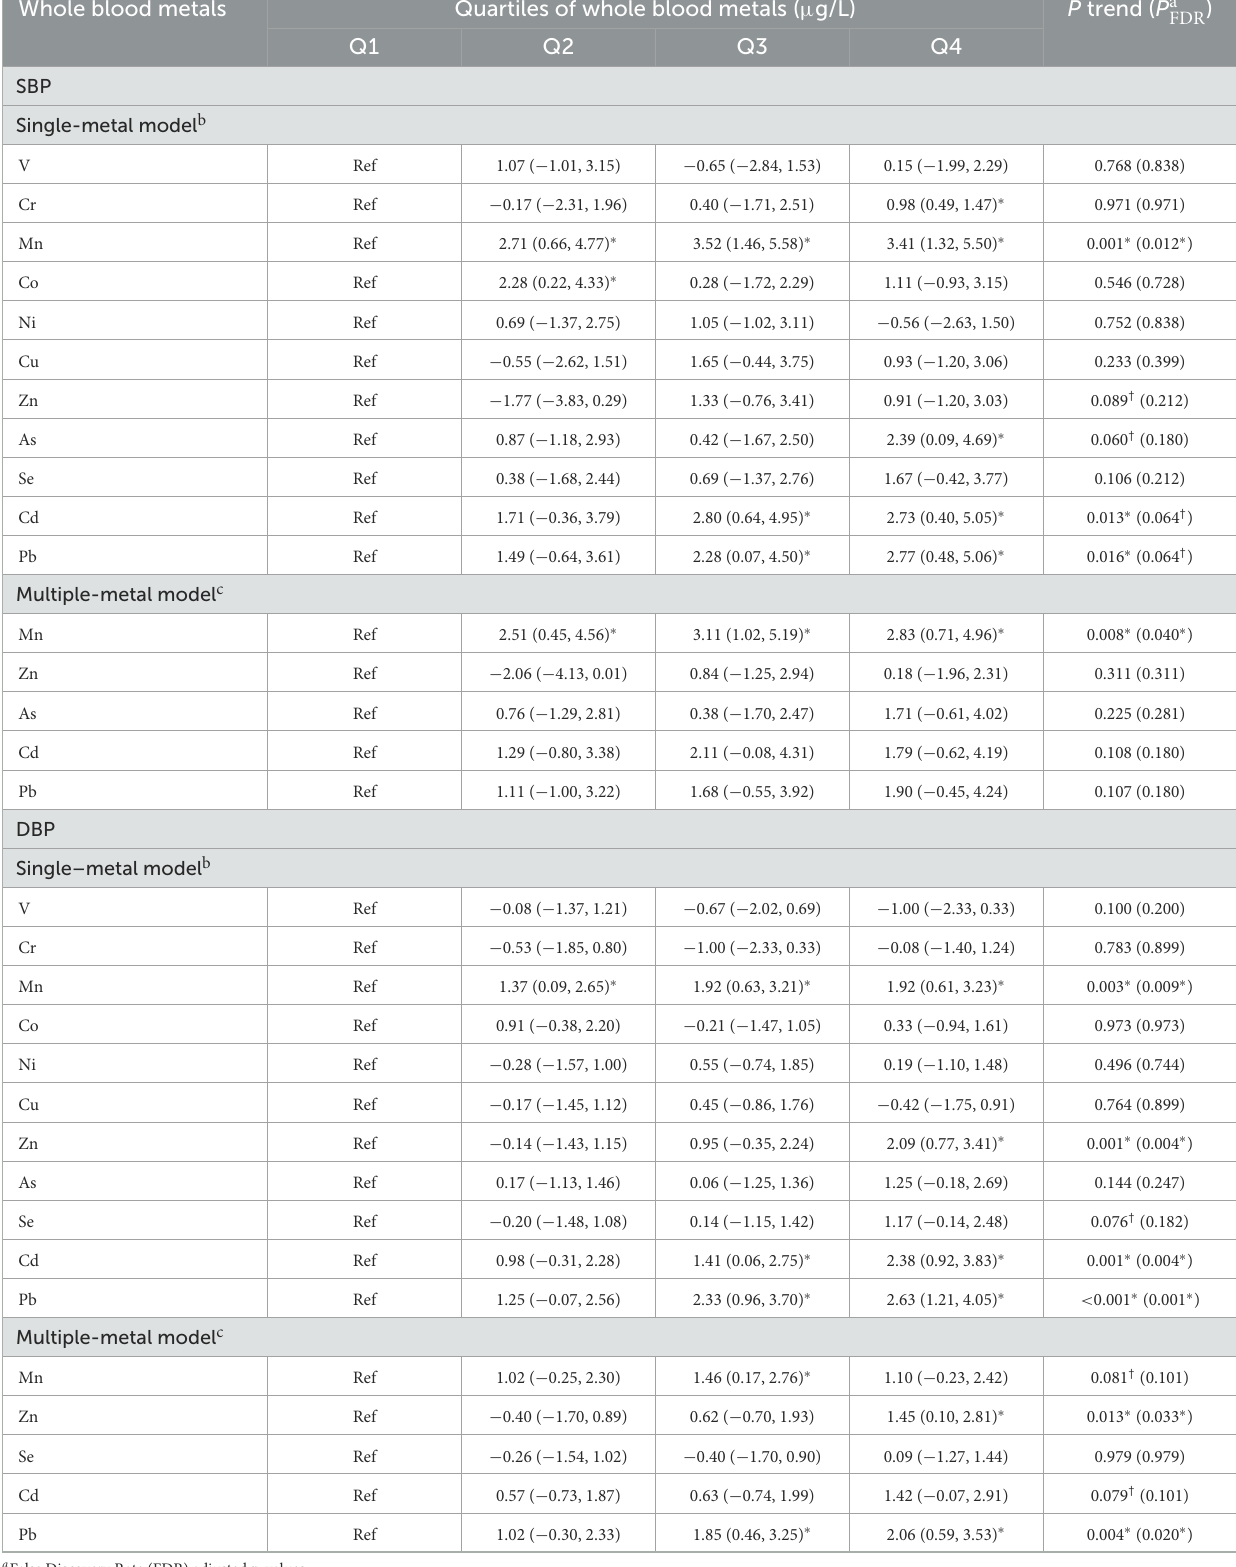
TABLE 3 Beta coefficients and 95% CI of blood pressures in generalized linear regression